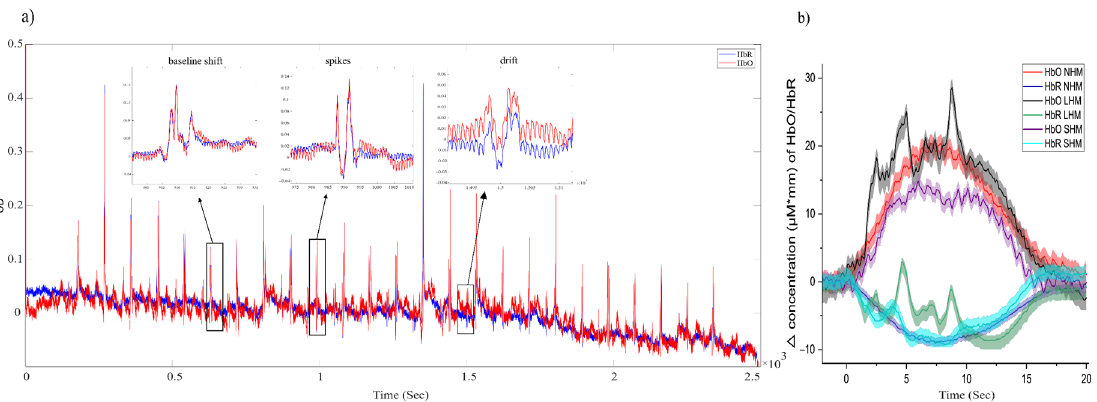
Figure 5. ( a ) An example raw time course of optical density signals of one participant (red: HbO, blue: HbR). The small insets exemplify different types of MA (baseline shifts, spikes with high amplitude and fast dynamics, and slow drifts with lower amplitude and slower dynamics) at a finer temporal scale. ( b ) Corresponding average uncorrected epochs of the raw concentration change of HbO/HbR for the three movement conditions. Different levels of movement artifacts distort the tapping related response to different extents, even after averaging. Colors codes conditions: red for HbO in NHM epochs, blue for HbR in NHM, black for HbO in LHM epochs, green for HbR in LHM, purple for HbO in SHM, and cyan for HbR in SHM. Error bands indicate standard error across